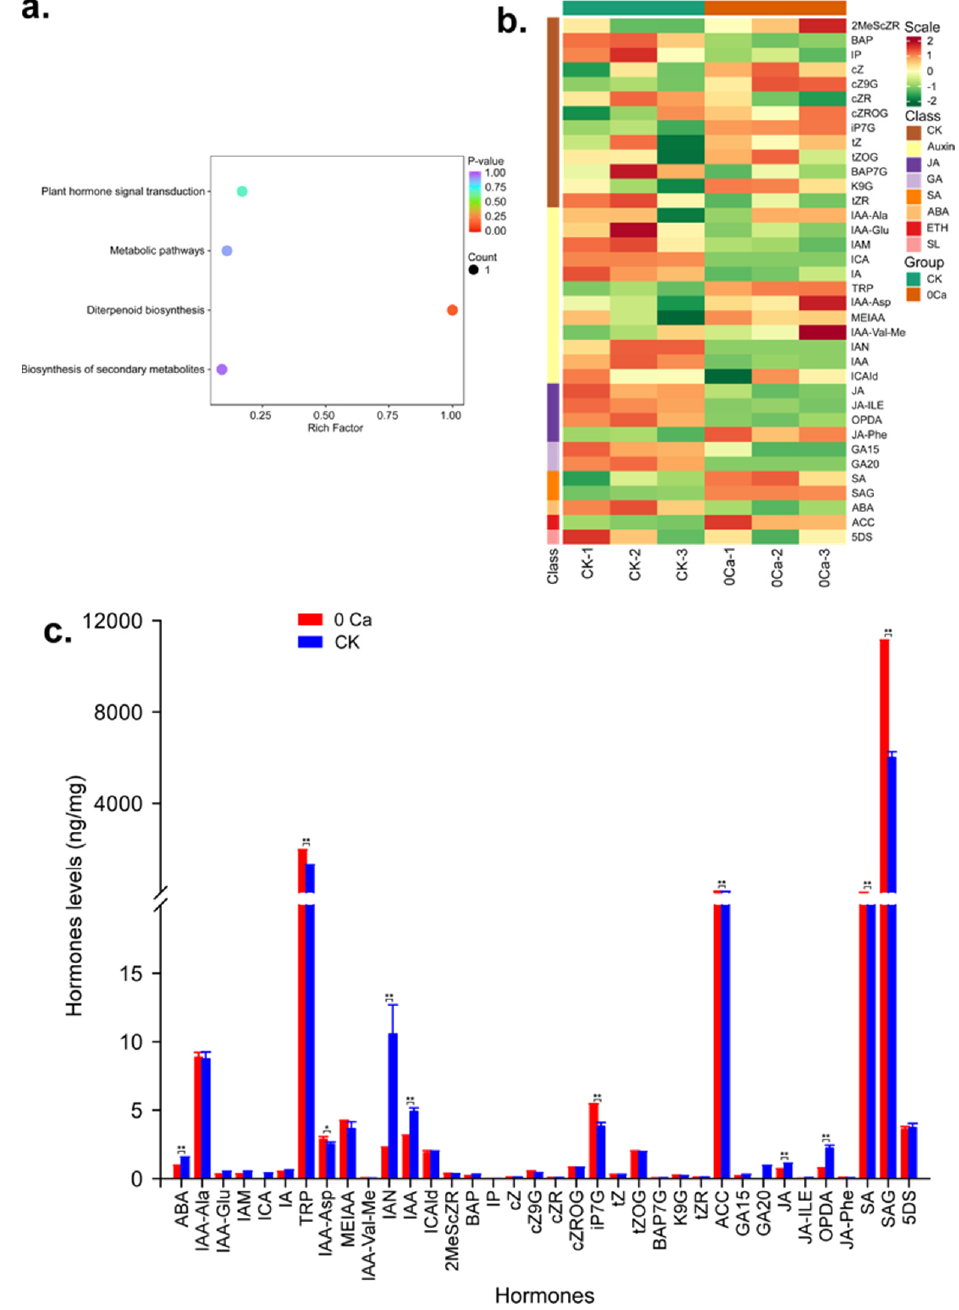
Figure 15. Hormone identification for metabolomic analysis. ( a ) KEGG enrichment of the DEMs. ( b ) Sample clustering diagram. ( c ) Histogram of hormone levels’ comparison between 0Ca and CK. Asterisks indicate statistical significance using Student’s t -test: *, p ≤ 0.05, **, p ≤ 0.01.